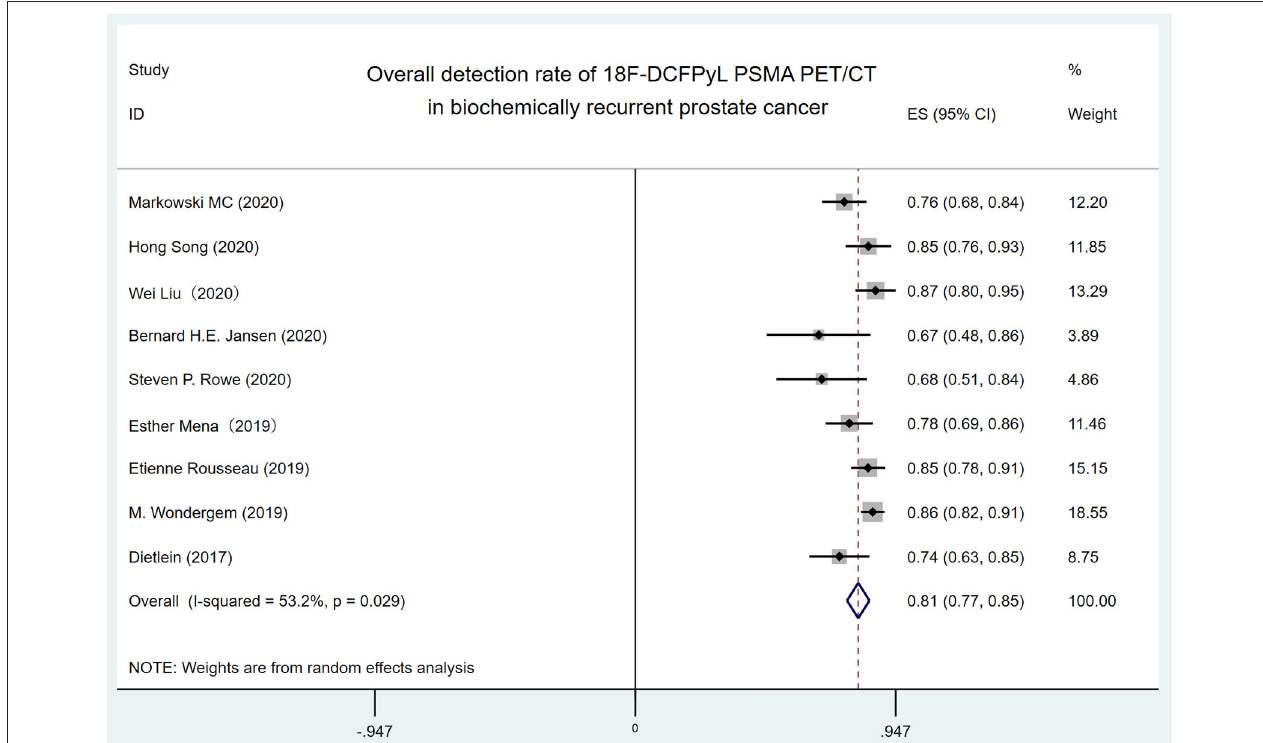
FIGURE 2 | Forest plot for overall detection rate of 18F-DCFPyL PSMA PET/CT in biochemically recurrent prostate cancer. 18F-DCFPyL, 2-(3-{1-carboxy-5-[(6-[18F] fluoro-pyridine-3-carbonyl)-amino]-pentyl}-ureido)-pentanedioic acid; PSMA, prostate-specific membrane antigen; PET/CT, positron emission tomography/computed